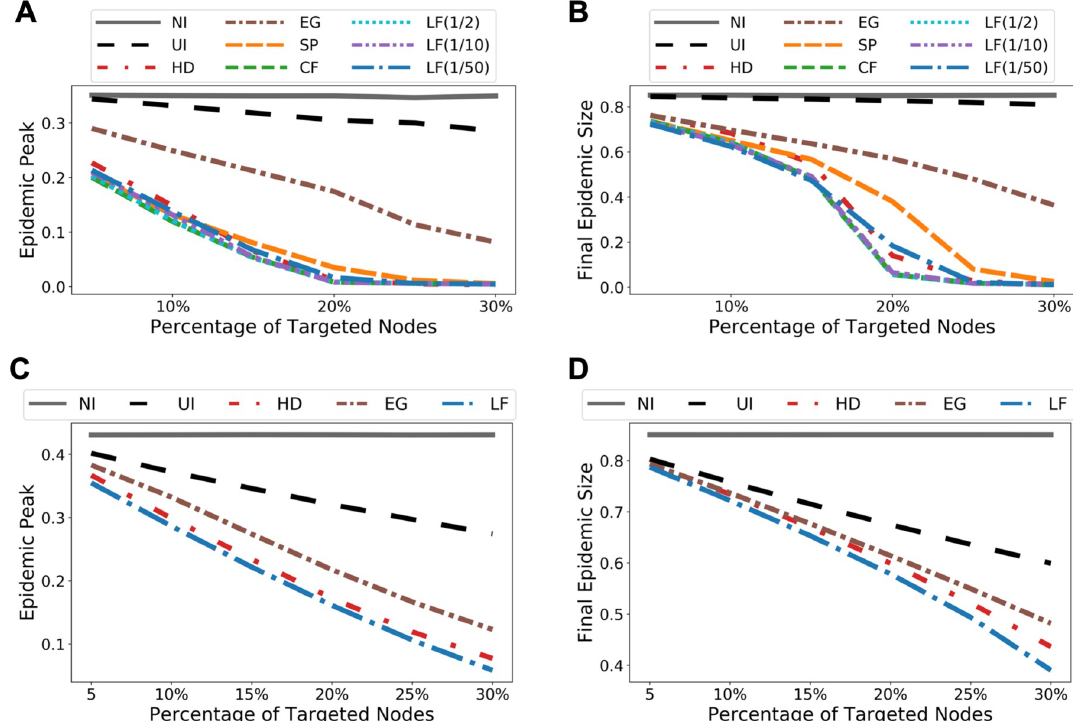
Fig 11. Simulation results for node immunization on sub-sampled and full Portland networks. The results are obtained from agent-based SEIR model with random initializations and are averaged over 50 trials. (A) Predicted epidemic peaks, sub-sampled network. (B) Predicted epidemic sizes, sub-sampled network. (C) Predicted epidemic peaks, full network. (D) Predicted epidemic sizes, full